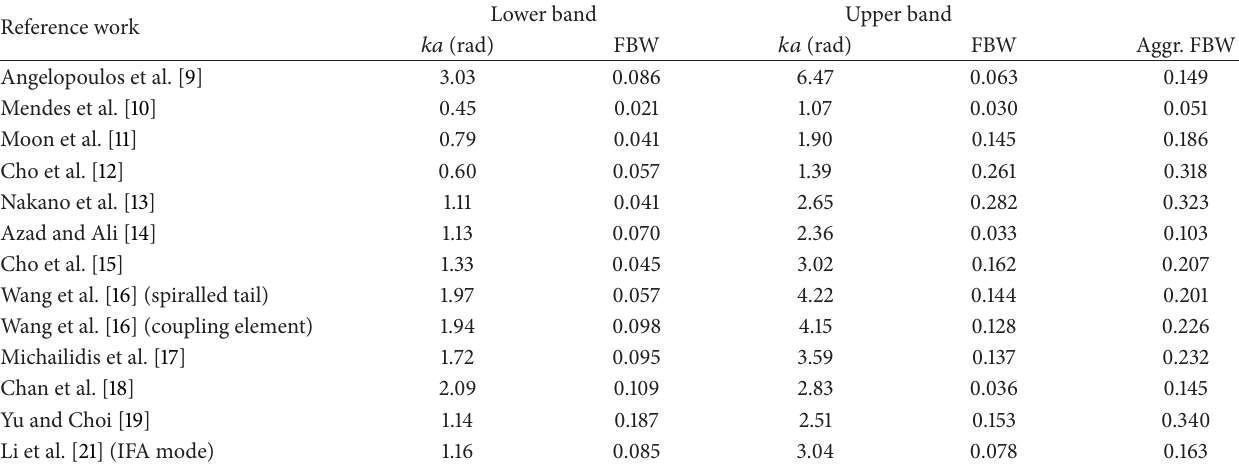
Table 6: Electrical sizes, fractional bandwidths, and aggregate fractional bandwidths from the literature survey.